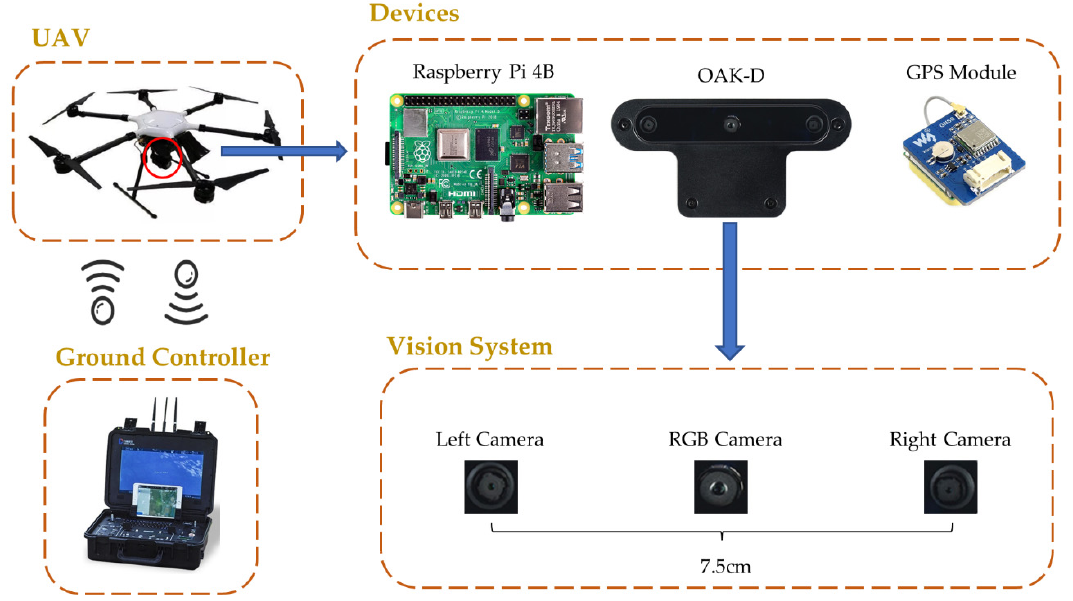
Figure 3. The composition of the hardware system, containing the UAV, the ground controller, the OAK-D camera, the Raspberry Pi controller, and the GPS